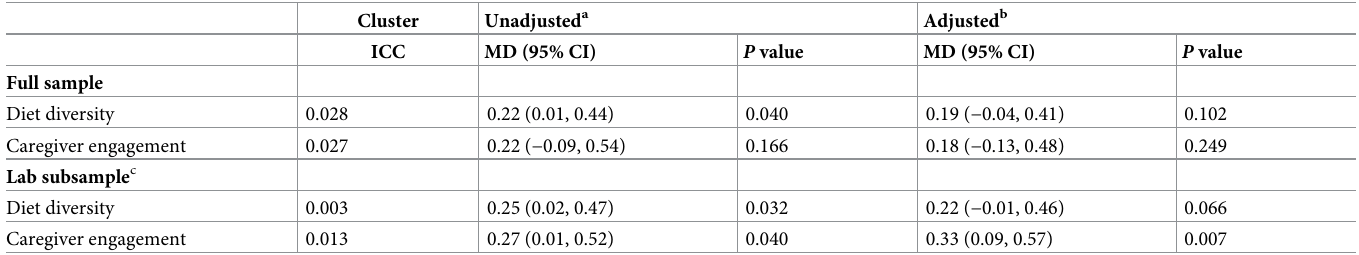
Fig 3. Impact on SRT by wave. SRT, saccadic reaction time. Notes: Marginal linear predictions based on estimates of treatment–wave interactions from adjusted linear mixed models. For F-test of hypothesis that treatment effects are equal at all waves: p = 0.193. Children were on average 7 months old at Wave 1, 17 months old at Wave 2, and 36 months old at Wave 3. The intervention period ended between Waves 2 and 3, when children were 24 months of age. https://doi.org/10.1371/journal.pmed.1004222.g003 Table 3. Impact on exploratory